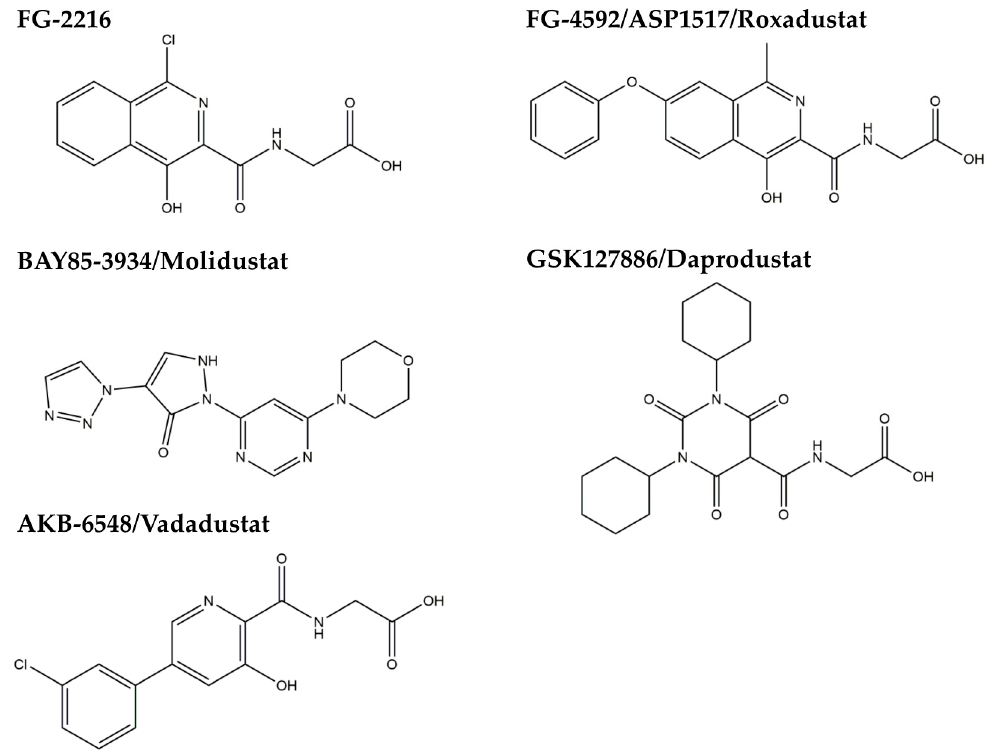
Figure 4. Chemical structures of HIF-PH inhibitors.